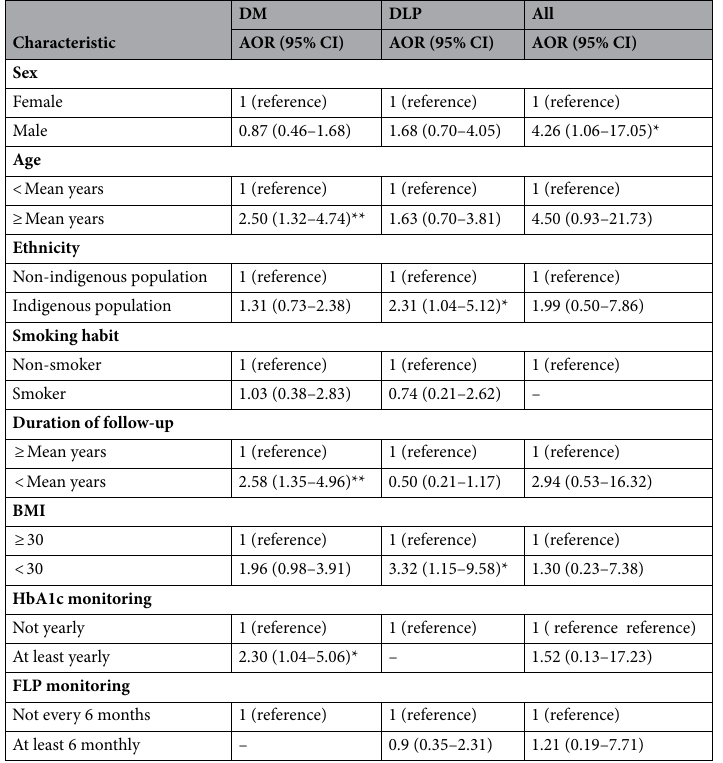
Table 3. Adjusted odds ratio (AOR) and 95% confidence interval (CI) of factors for therapeutic target achievement. * P < 0.05; ** P <